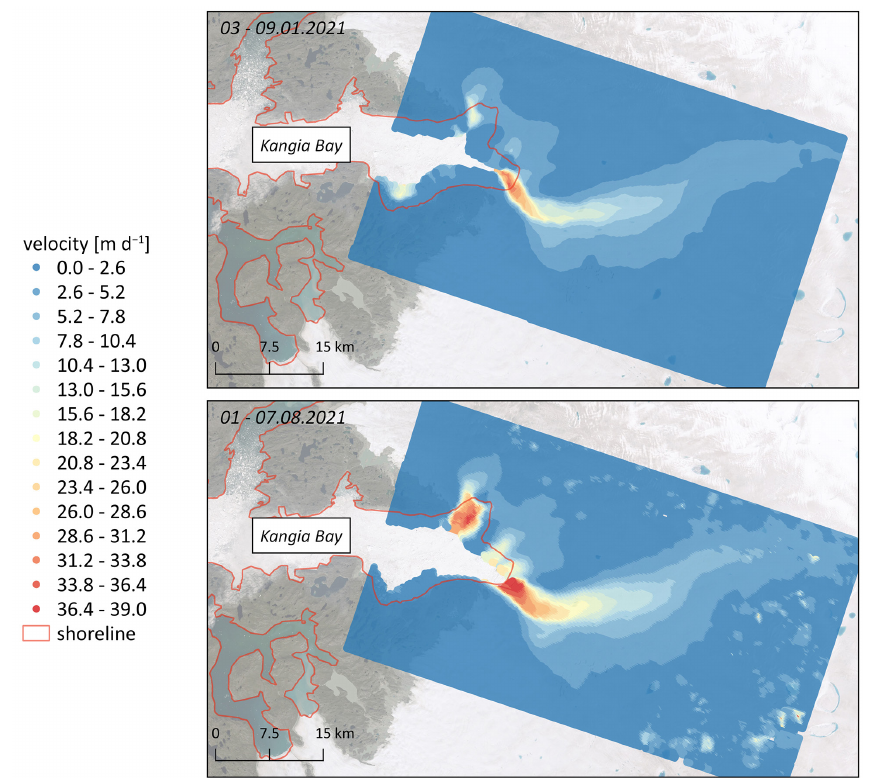
Fig. 8. Velocities of the Jakobshavn Glacier in winter and summer 2021.